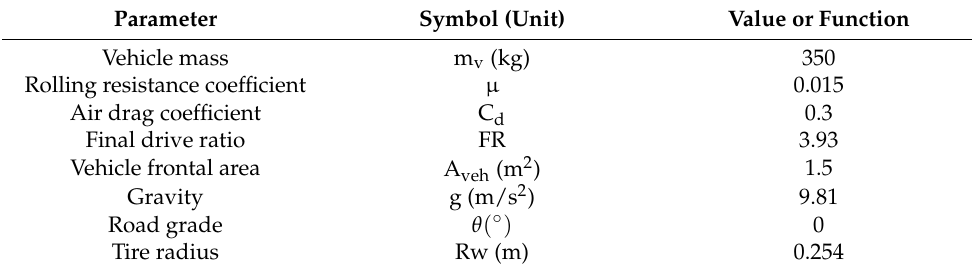
Table 3. Vehicle parameters and road